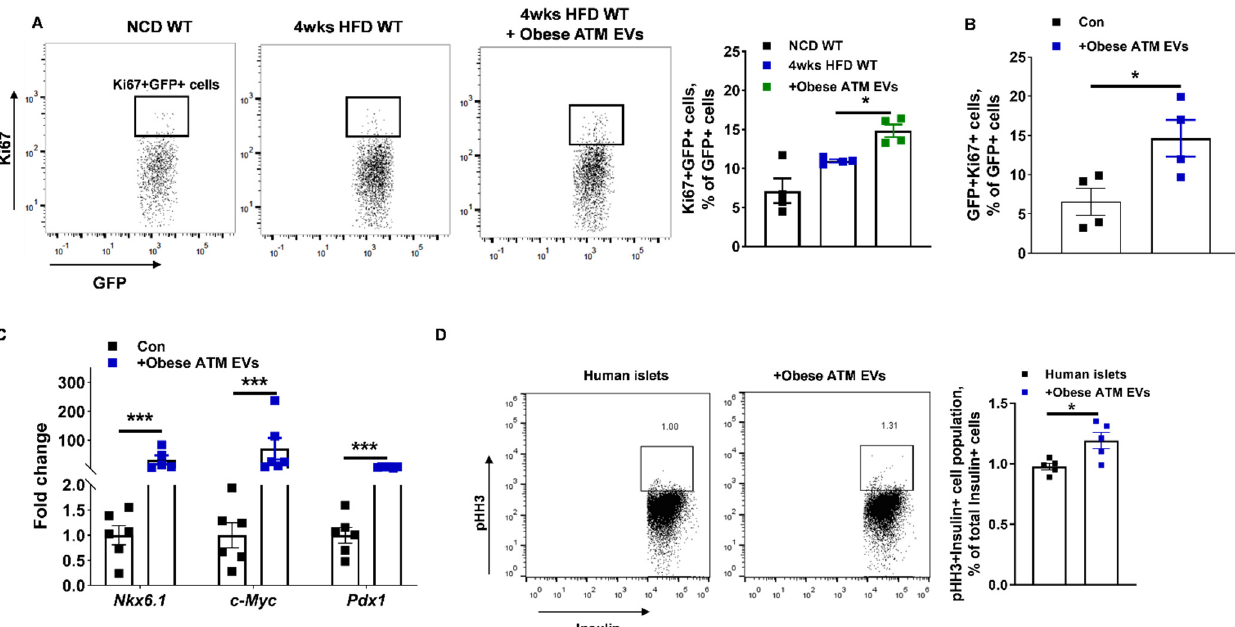
Figure 3. Obese ATM EVs enhance β cell proliferation in response to obesity. ( A ) The population of Ki67+GFP+ cells in the islets isolated from NCD MIPGFP-Mki67 WT, 4 weeks HFD MIPGFP-Mki67 WT, or 4 weeks HFD MIPGFP-Mki67 WT mice treated with obese ATM EVs. ( B ) The in vitro effect of obese ATM EVs on the Ki67+GFP+ cell proportion of NCD MIPGFP-Mki67 islets. ( C ) The abundance of genes associated with β cells proliferation after 72 h obese ATM EV treatment. ( D ) Effect of obese ATM EVs on the population of pHH3+Insulin+ cells in human islets. Data are presented as the mean ± SEM. N = 3–4 ( A and B ), N = 6 (C), N = 5 ( D ) per group. * p < 0.05, *** p < 0.001, Student’s t test ( B – D ) or one-way ( A )